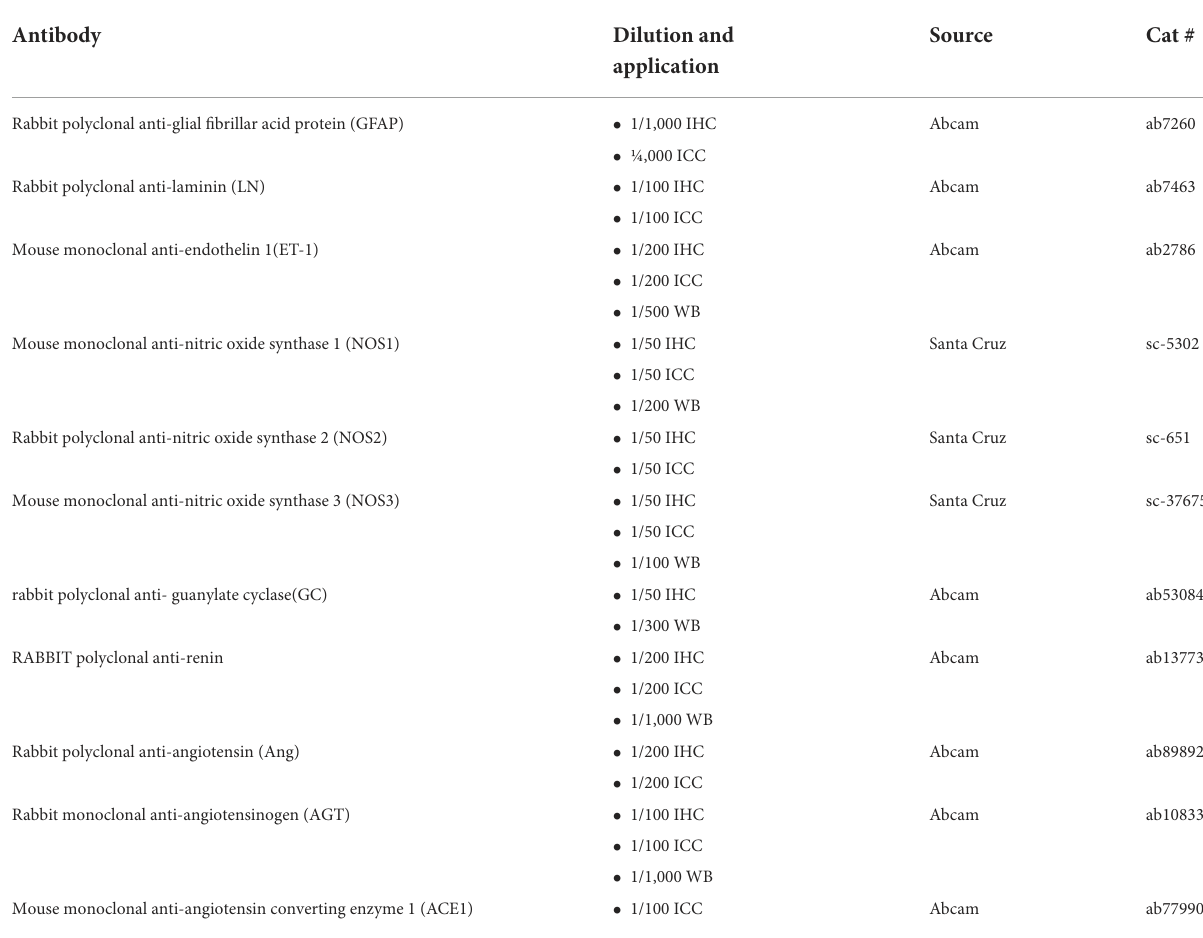
TABLE 1 List of antibodies.